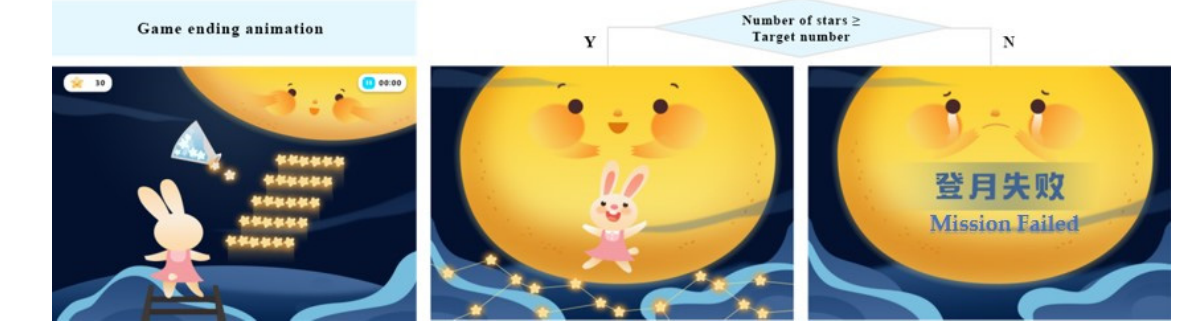
Figure 13. Examples of the feedback animation after one round of training (authors’ proposal).